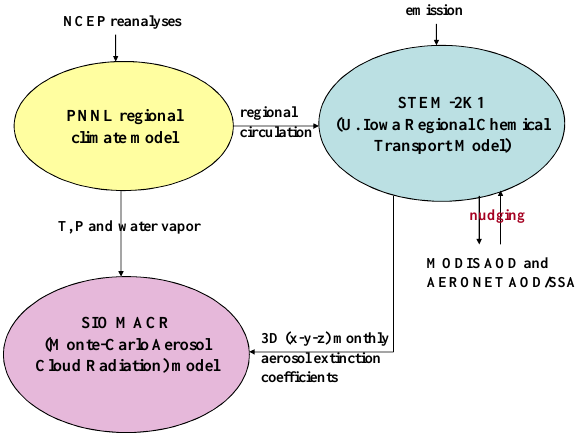
Fig. 1. Overview of the Asian aerosol assimilation project. Figure 1. Overview of the Asian aerosol assimilation project. The project has been a joint effort between Scripps Institution of Oceanography (SIO), Pacific Northwest National Laboratory (PNNL) and the University of Iowa. The SIO MACR (Monte- Carlo Aerosol Cloud Radiation) model took aerosol simulations from Iowa STEM-2K1 (Sulfur Transport Deposition Model), mete- orological variables from the PNNL regional model, and cloud from the ISCCP, so as to produce 2001–2004 aerosol radiative